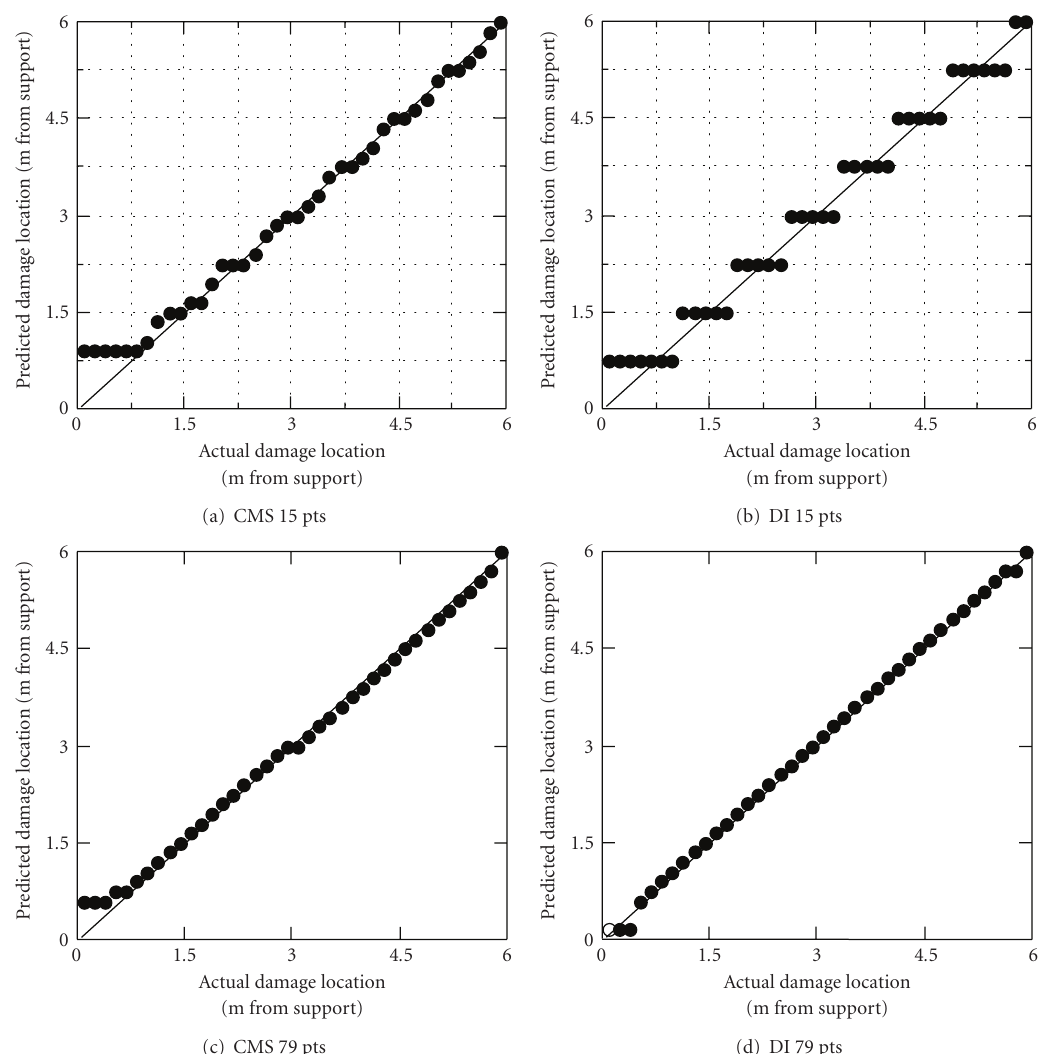
Figure 12: Correlation between predicted and actual damage locations, calculated using 15 measurement points by (a) the CMS and (b) the DI methods; and calculated using 79 measurement points by (c) the CMS and (d) the DI